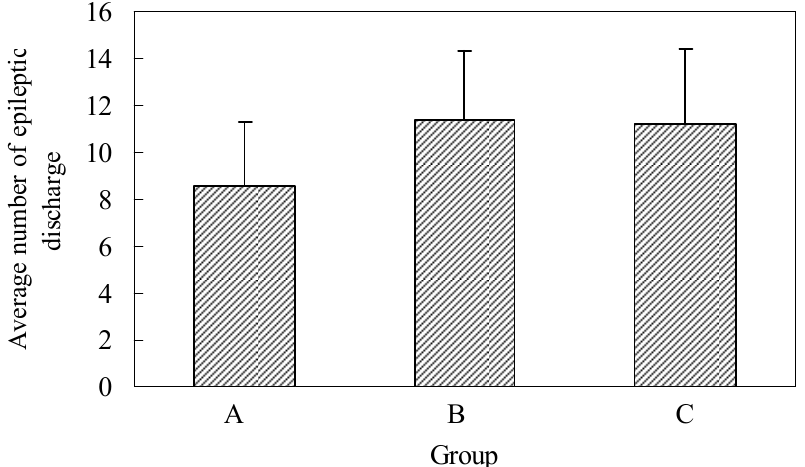
Figure 5. Average number epileptic discharge during 60 min. EEG registration in full kindling.